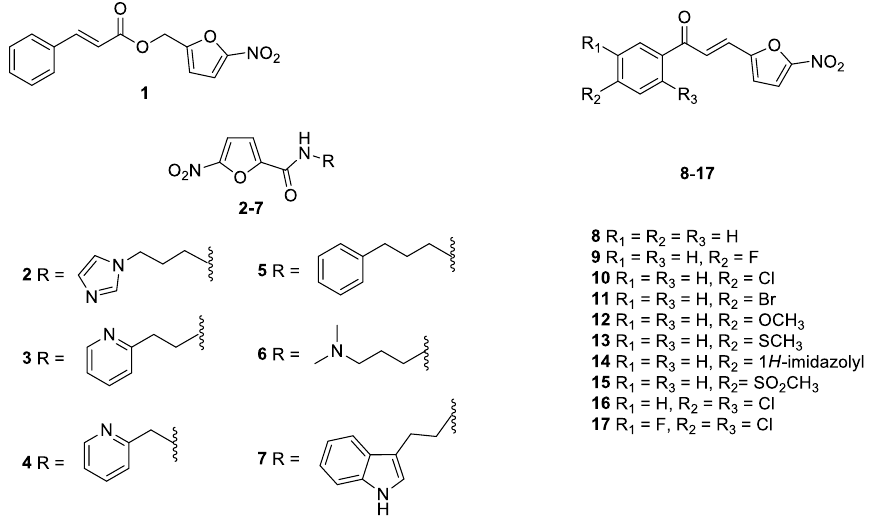
Figure 1. Nitrofuran derivatives 1 – 17 studied in this work.